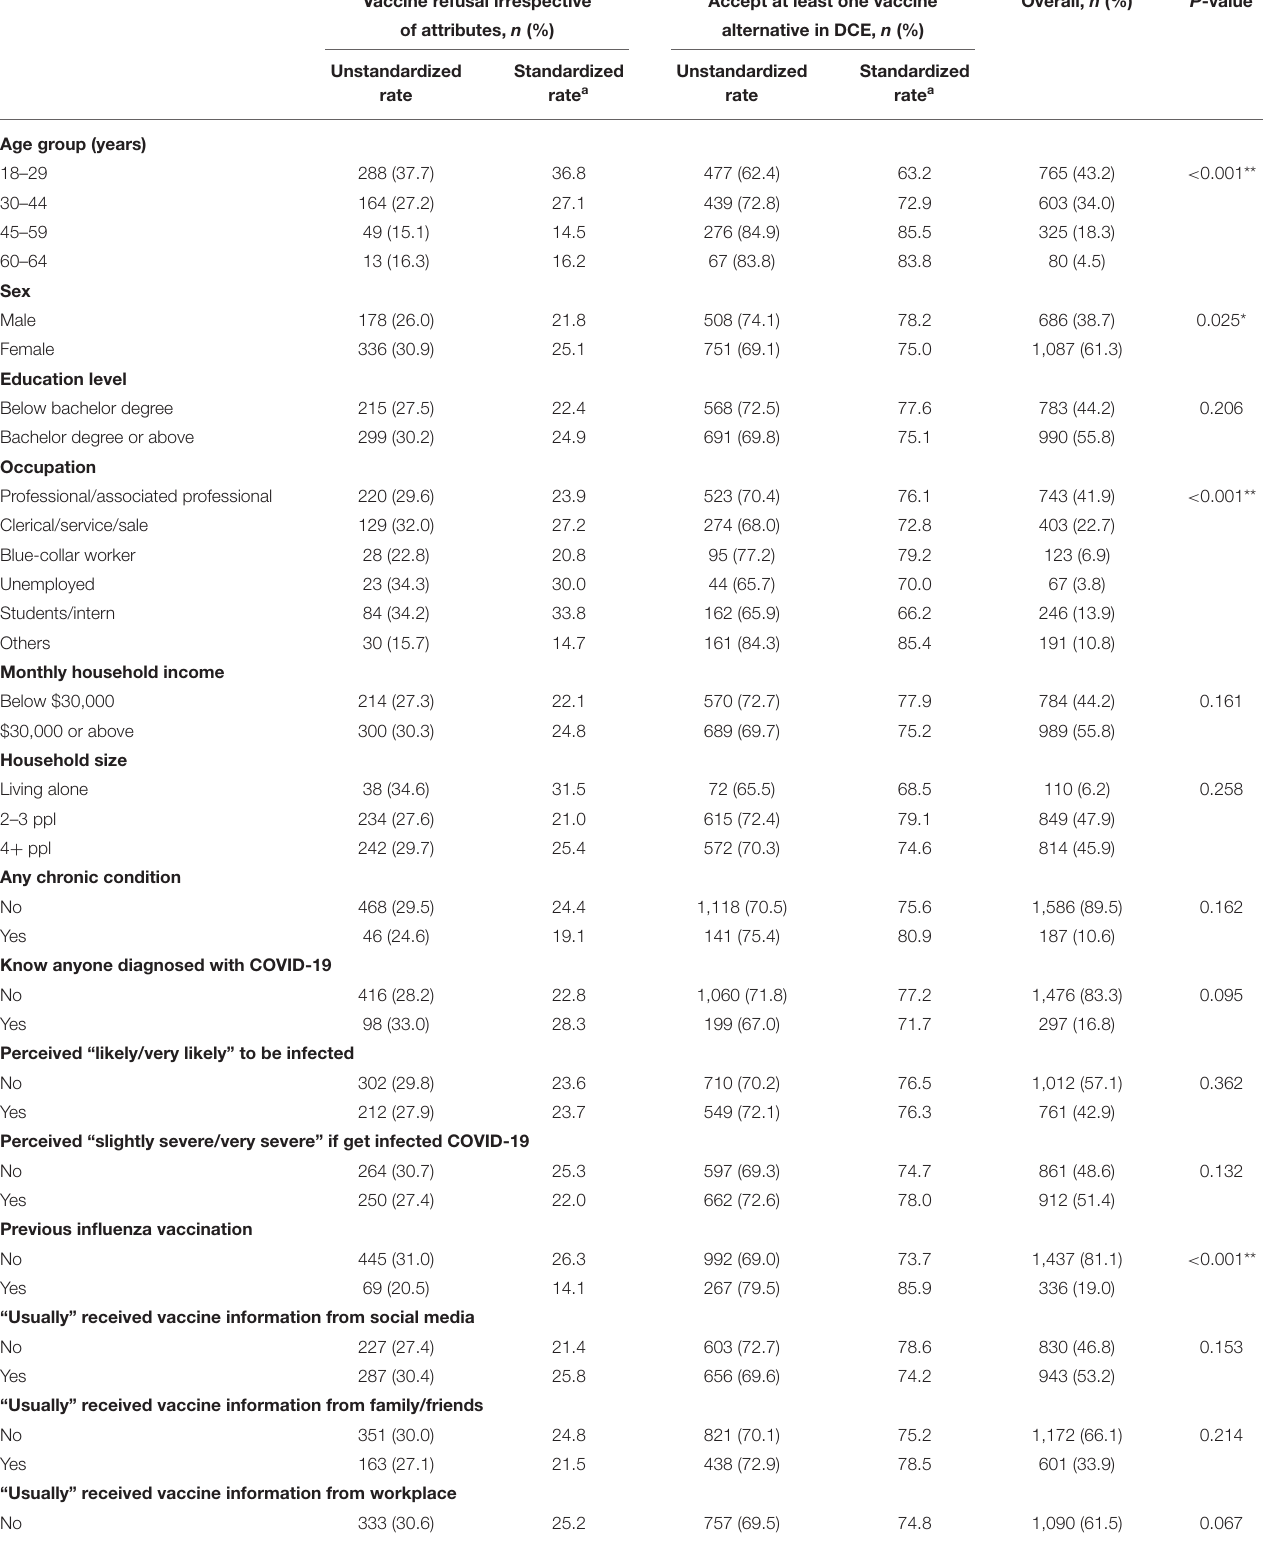
TABLE 3 | Sample characteristics and rate of vaccine refusal by subgroups. Vaccine refusal irrespective Accept at least one vaccine Overall, n